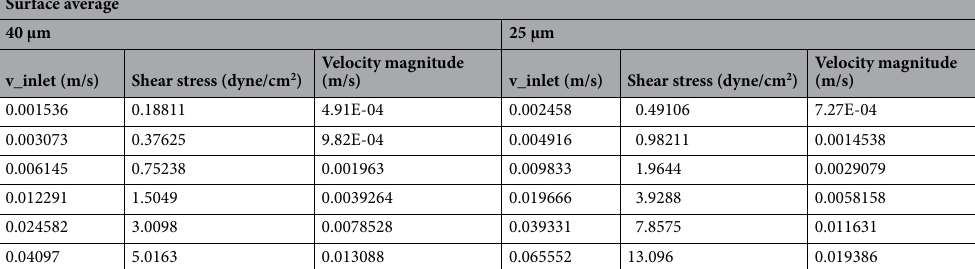
Table 3. Surface average of shear stress and velocity for two microfluidic chips with 40 μm and 25 μm microchannels.